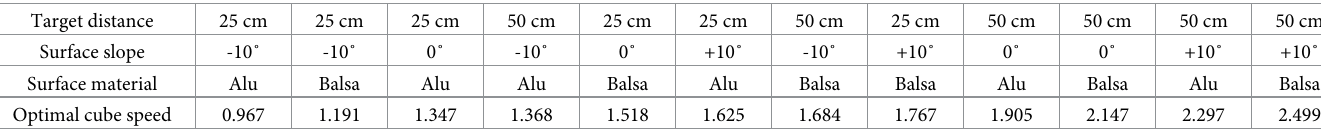
cube’s front edge as a percentage of target distance, with positive values for overshoots and negative values for undershoots. Motor adaptation was investigated by fitting an exponential